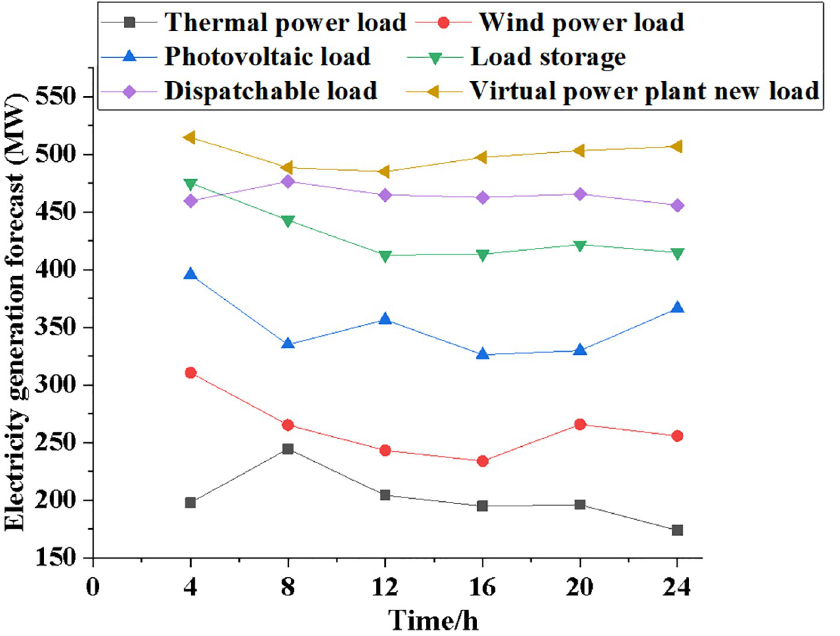
Fig 8. Variation trend of the forecast data of generated power for different power load